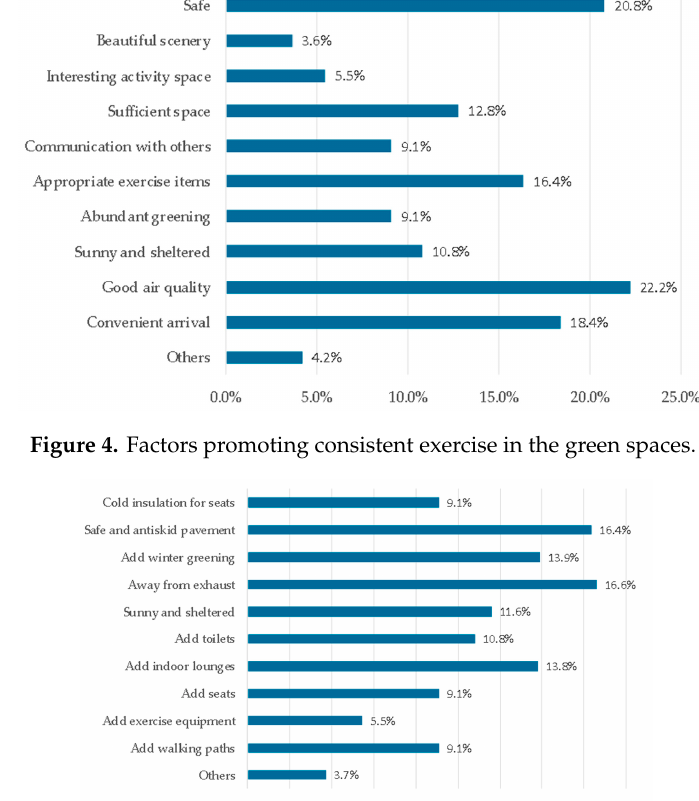
Figure 3. Factors hindering consistent exercise in the green spaces.